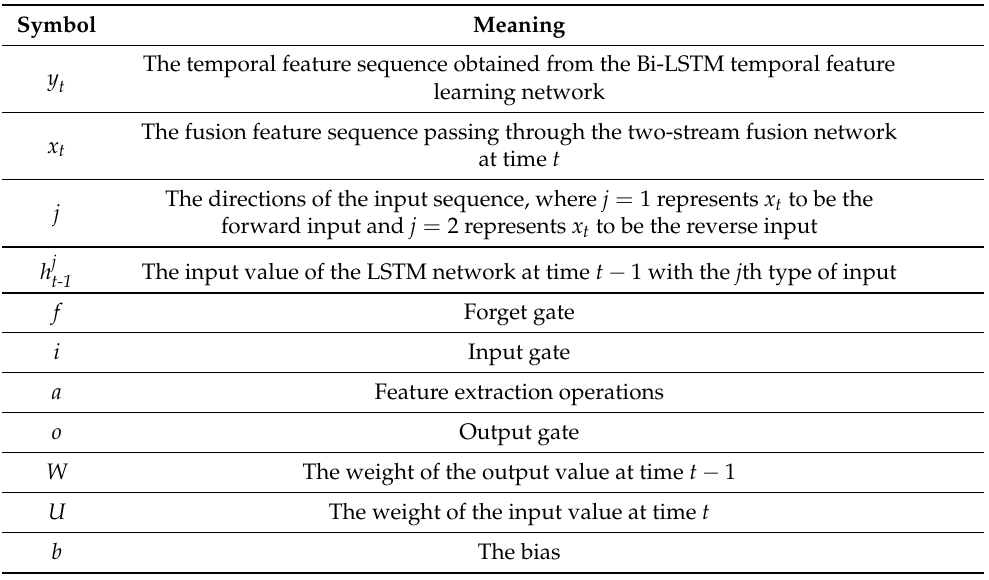
Table 2. The meaning of each symbol in the